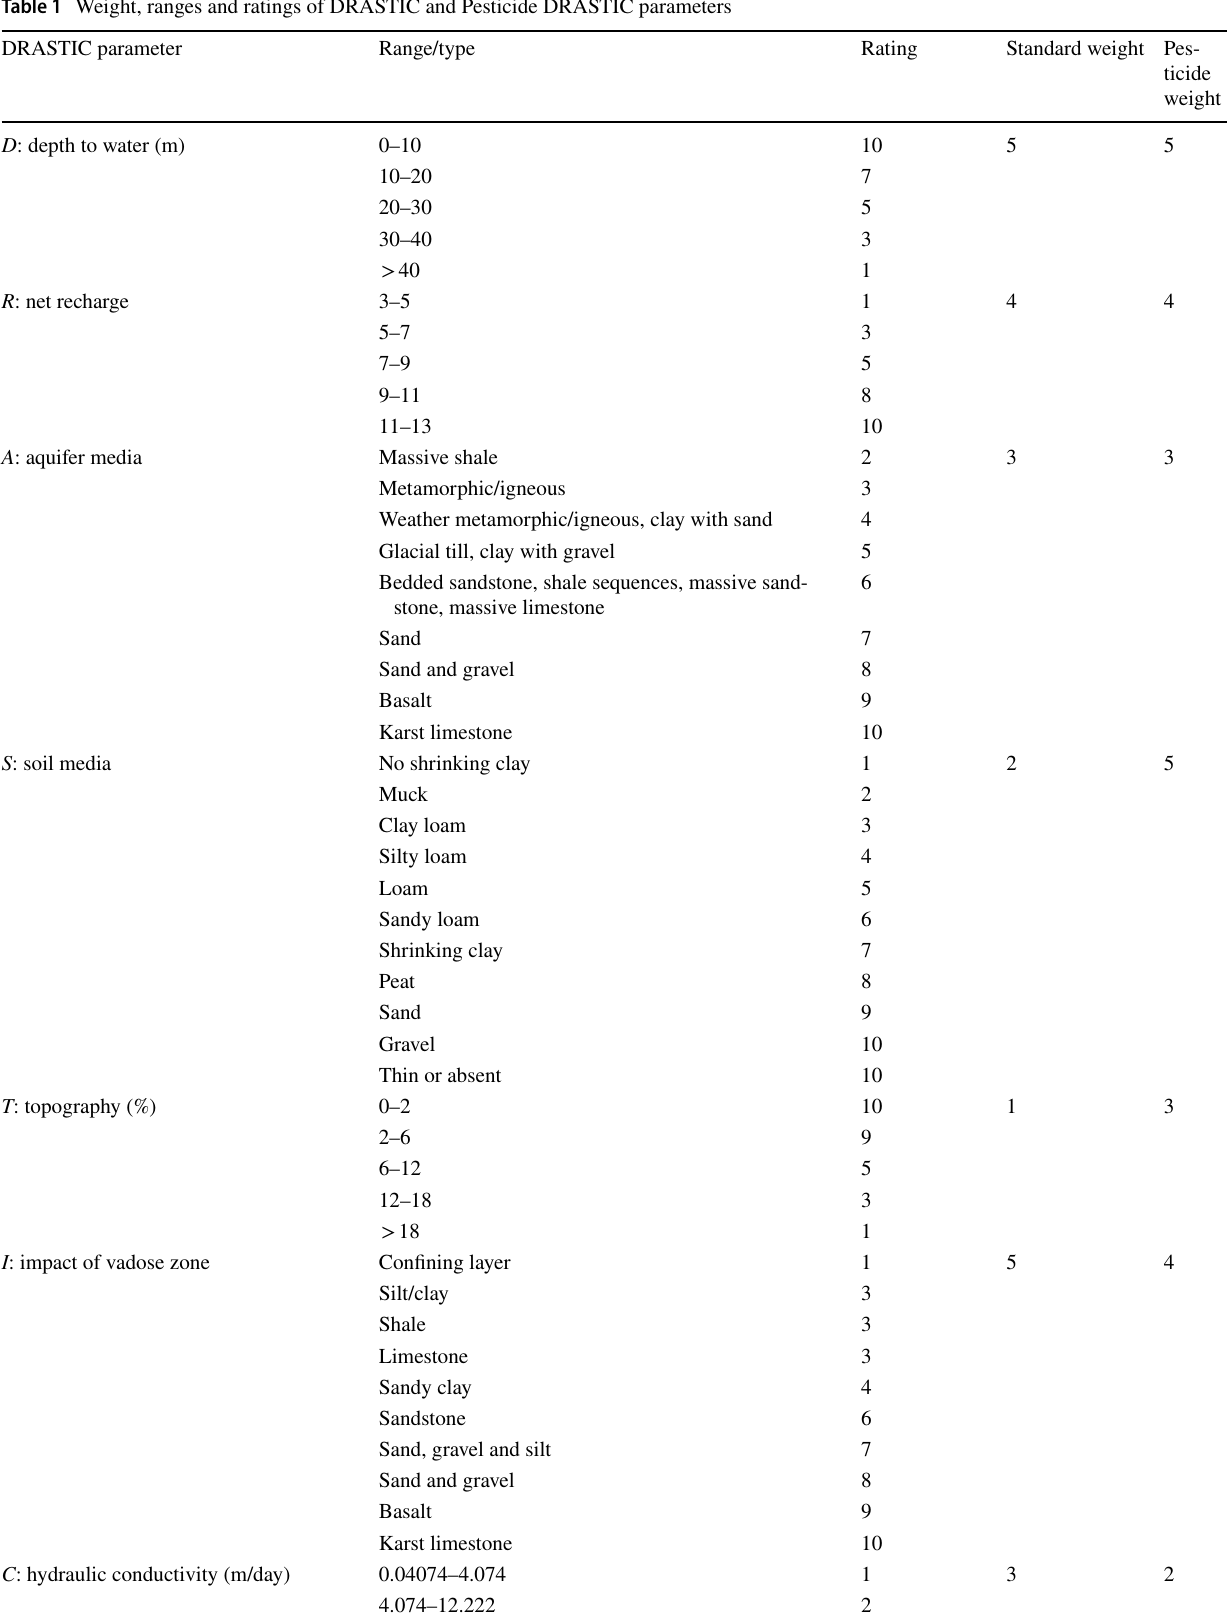
Table 1 Weight, ranges and ratings of DRASTIC and Pesticide DRASTIC parameters DRASTIC parameter Range/type Rating Standard weight Pes-